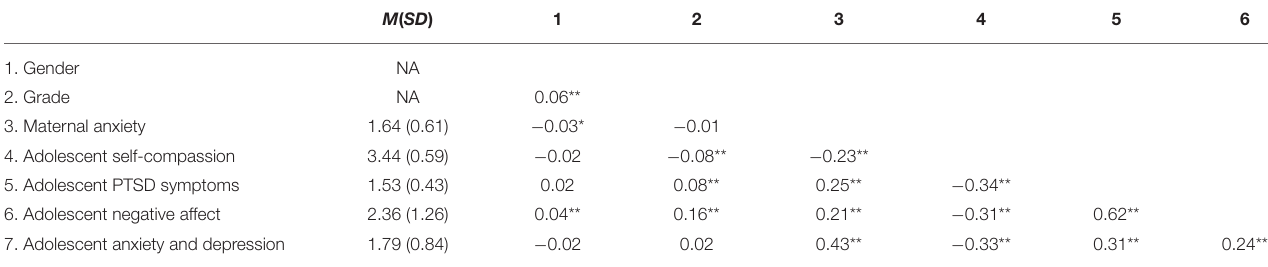
TABLE 2 | Descriptive statistics of and correlations among the study variables.